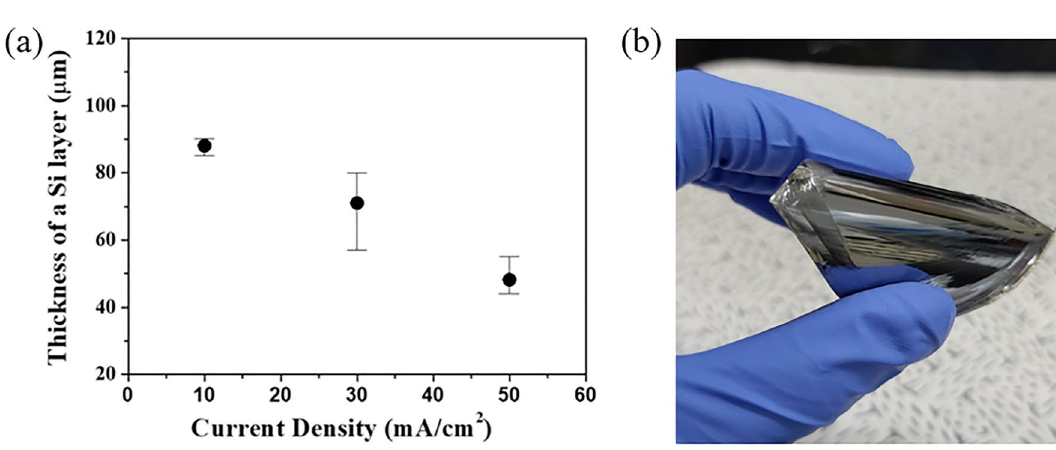
Figure 2. ( a ) The thickness of the exfoliated Si layer as a function of the applied current density in the electrochemical-assisted stripping process, ( b ) the image of exfoliated flexible silicon